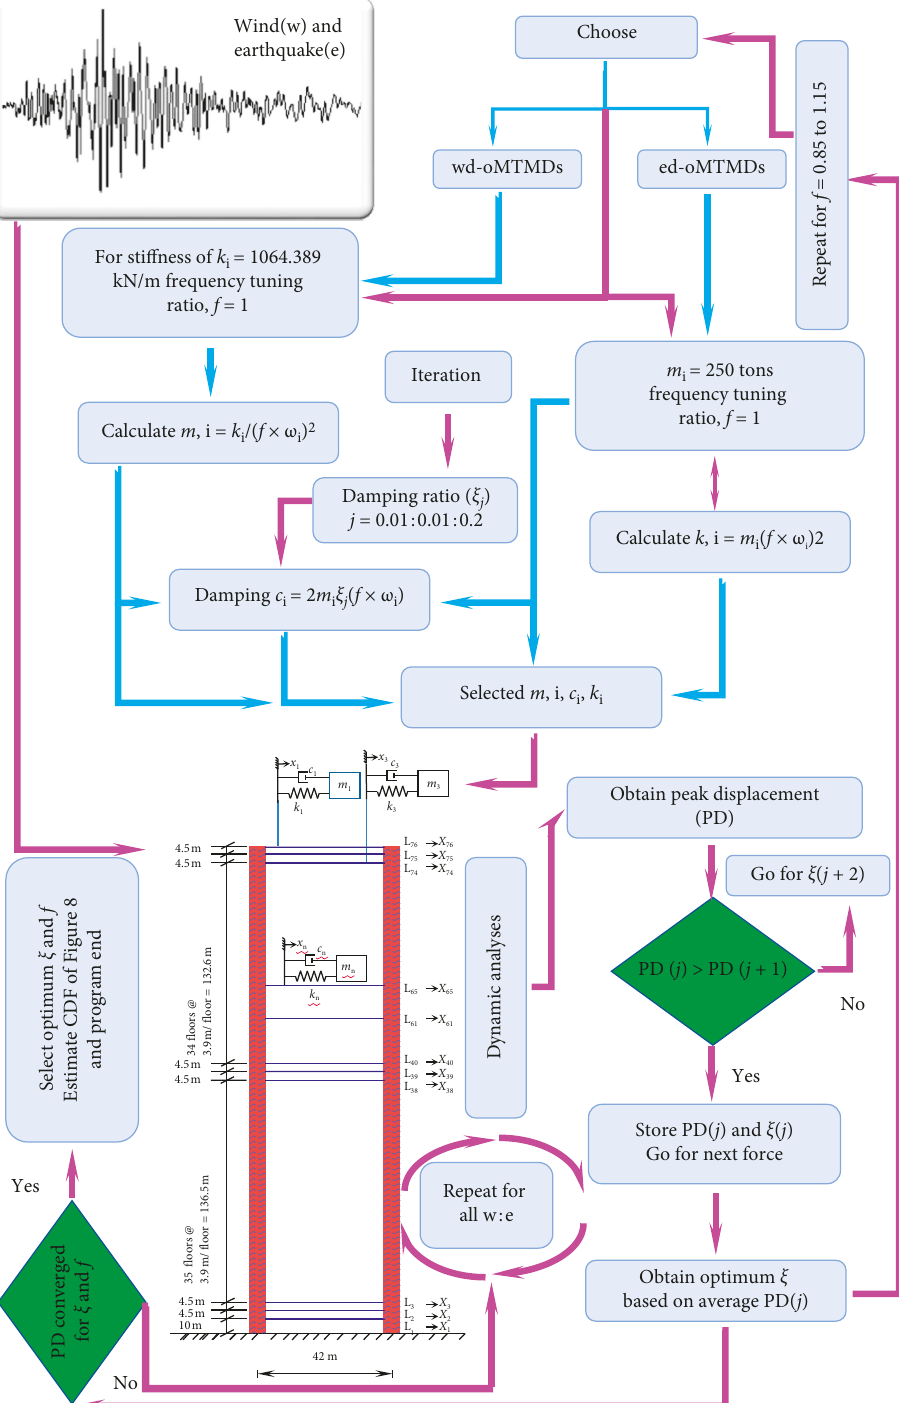
Figure 8: Flowchart for optimum design of d-MTMD for response reduction of buildings under wind and earthquake